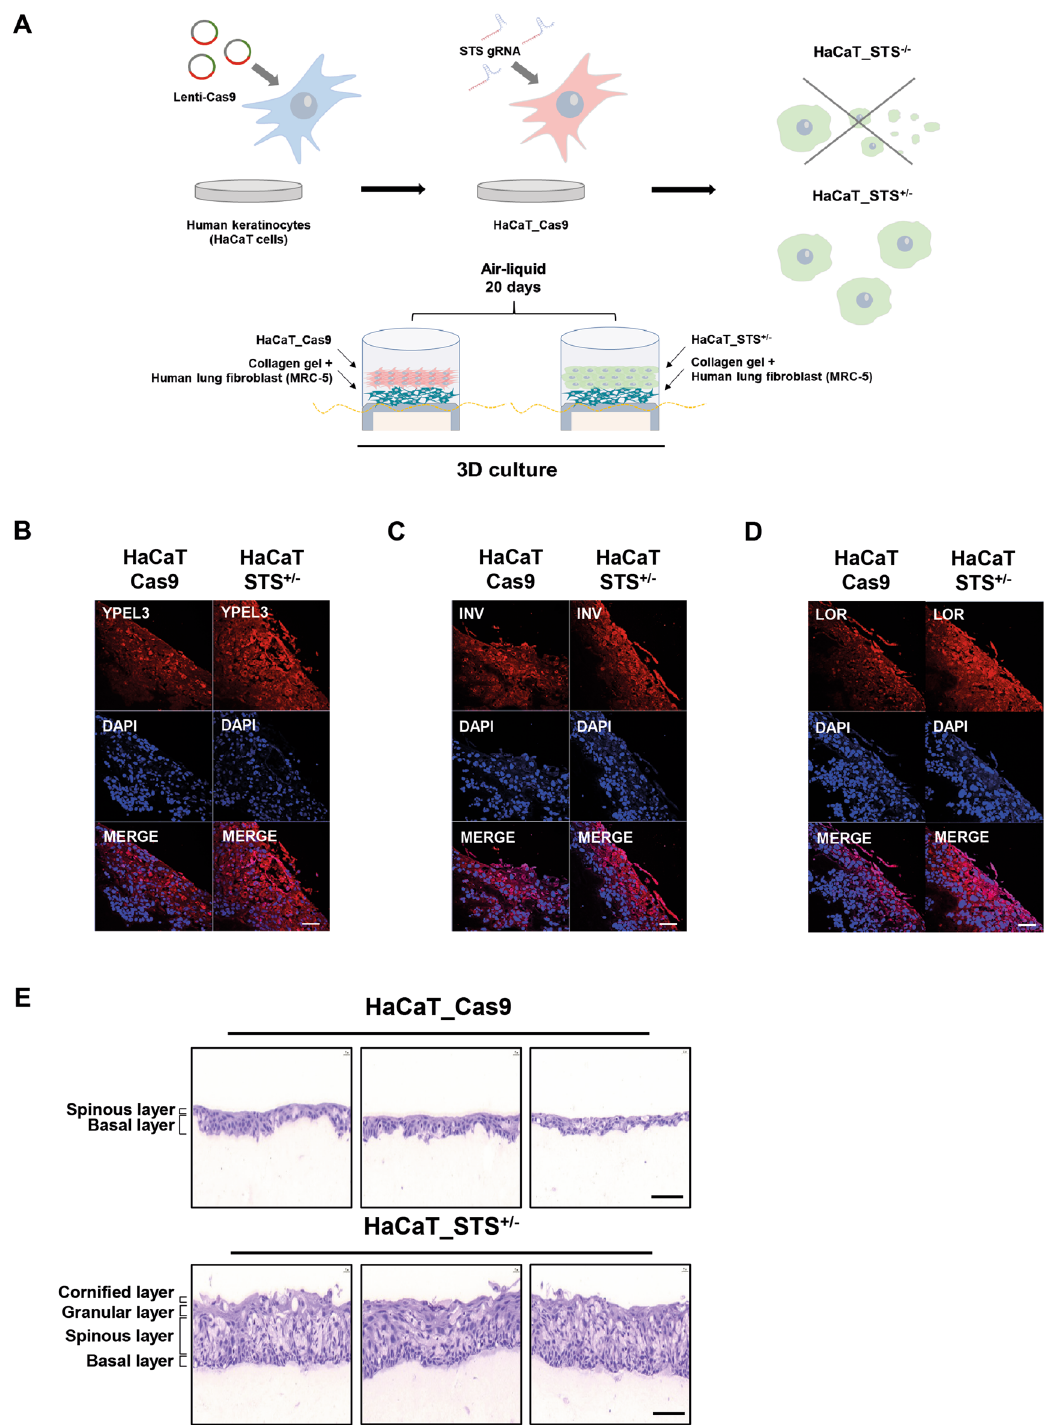
Figure 5. 3D skin culture using HaCaT_STS +/− cells. ( A ) Schematic diagram of 3D culture using HaCaT_ STS +/− cells. Confocal analysis was performed to assess ( B ) YPEL3, ( C ) Involucrin, ( D ) Loricrin expression. Microscopy scale bar = 50 μm. ( E ) Differences of formation of skin-layer were measured by H&E staining. Microscopy scale bar = 100